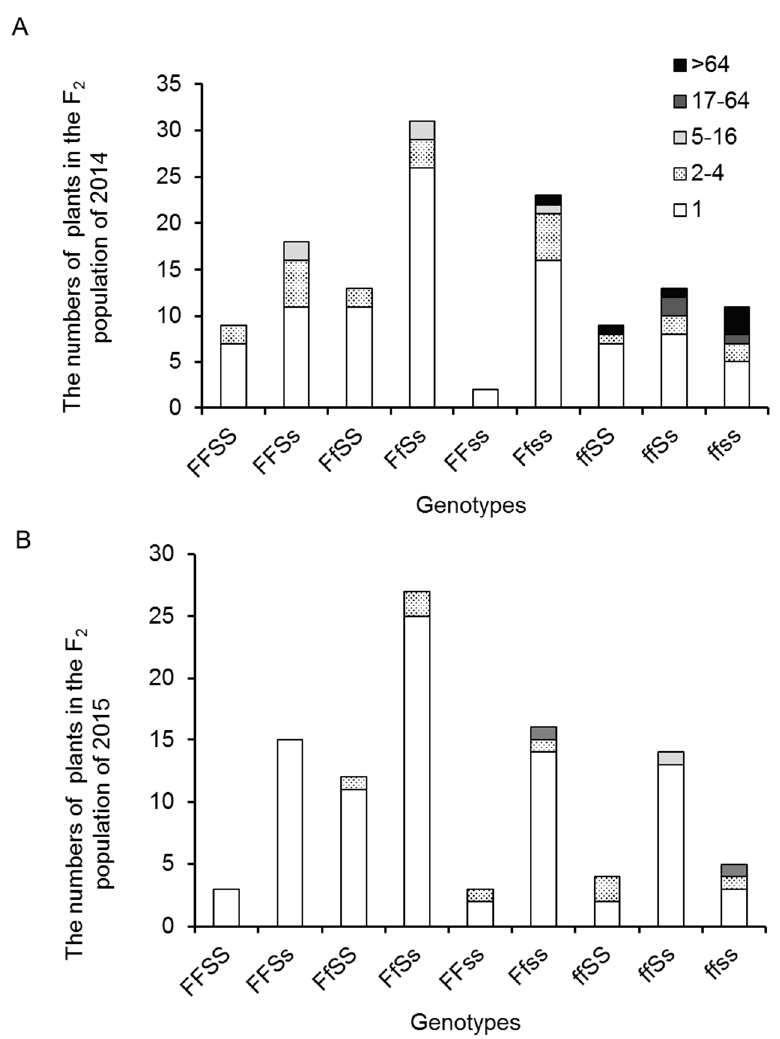
Figure 5. The relationship between BN and genotypes with reference to the candidate genes in F 2 populations of 2014 ( A ) and 2015 ( B ). Plant branch type (defined by the median of BN of the plant) were categorized into 1, 2–4, 5–16, 17–64, and more than 64 branches. Frequency distribution of BN groups of the nine genotypes for the FA and S genes in the F 2 population of 2014 is shown. S/s represents S gene allele; F/f represents FA gene allele. S and F alleles are derived from PI124039; s and f alleles are derived from 10AS111A.